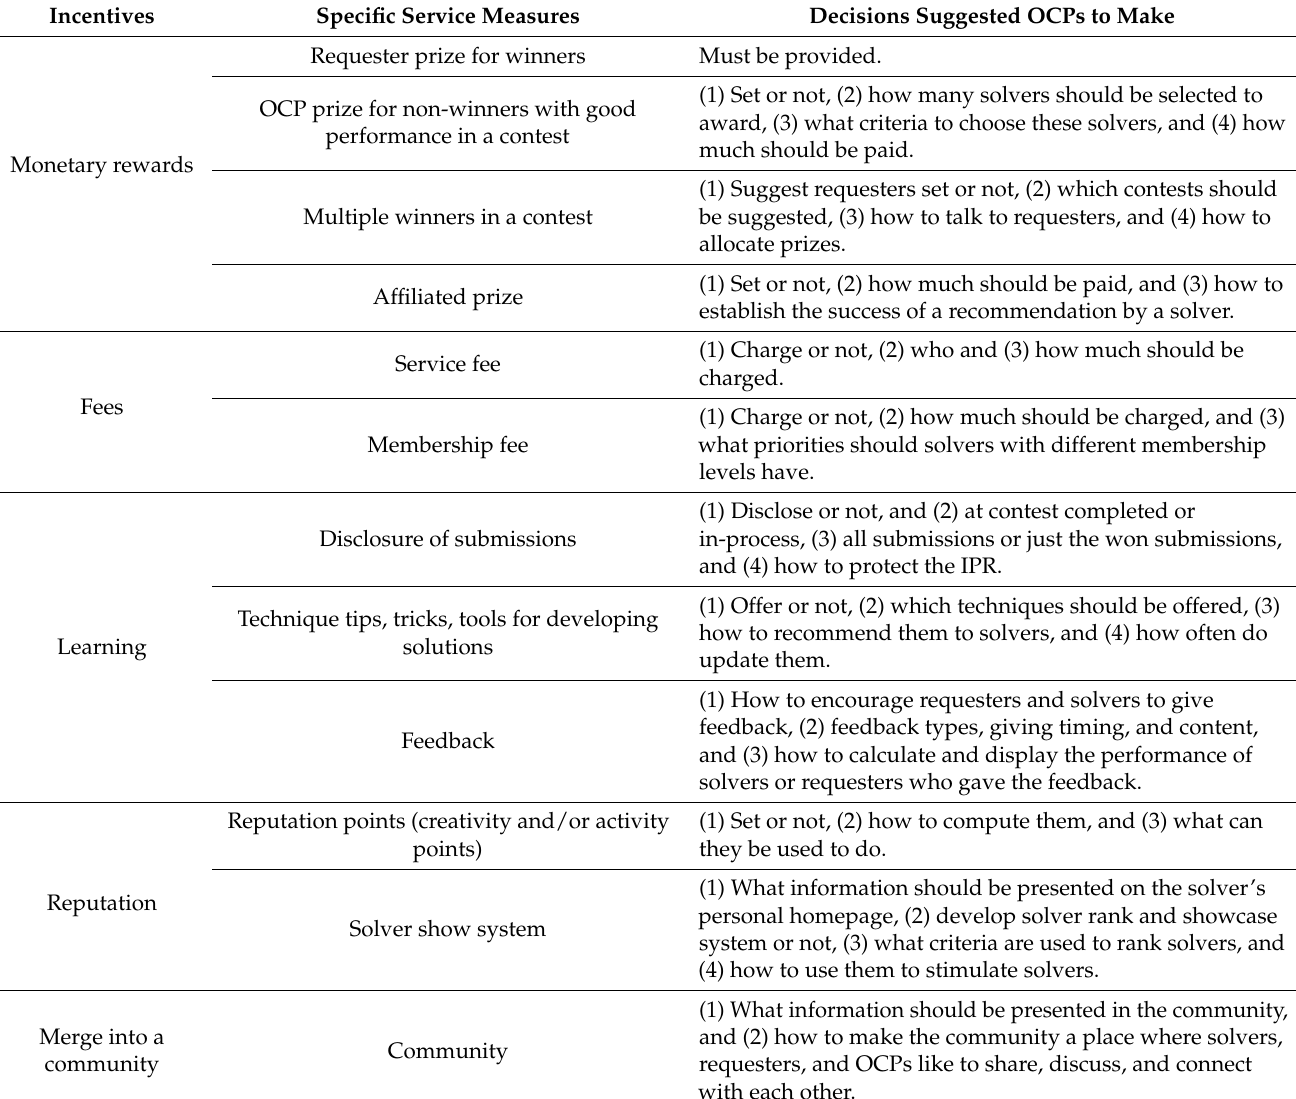
Table 4. Design decisions of service